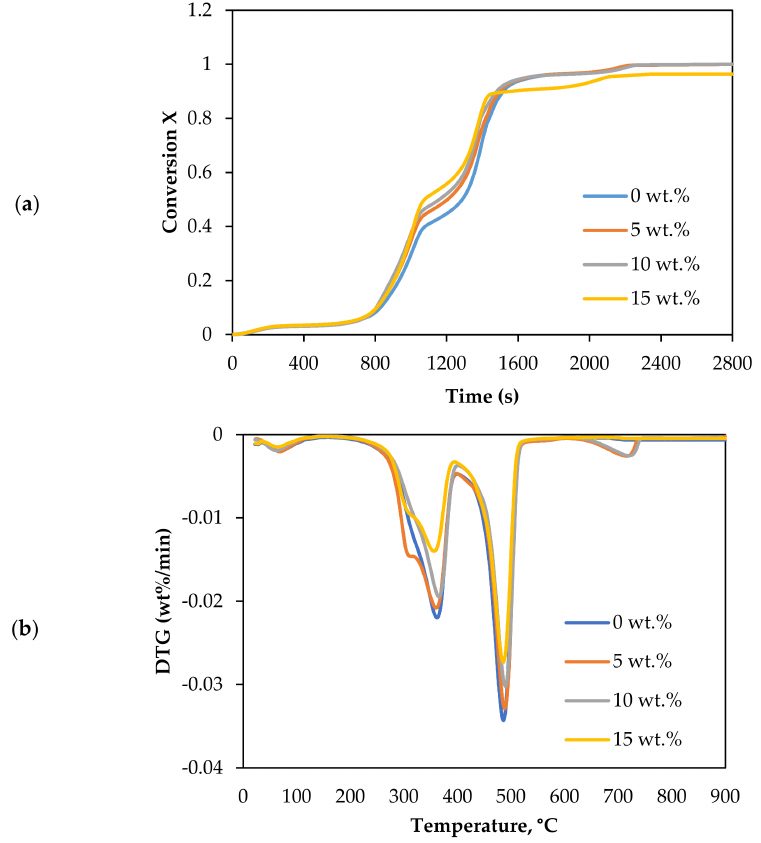
Figure 3. Effect of dolomite loading on the CO 2 gasification: ( a ) conversion degree, and ( b ) DTG